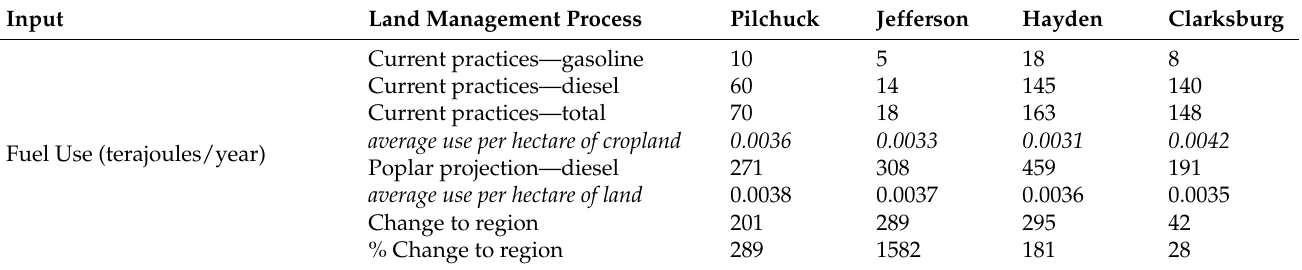
Table 8. Fuel use. Farm management only; no transportation of crops beyond farm exit gate. Average use of inputs per hectare of land for each region shown in